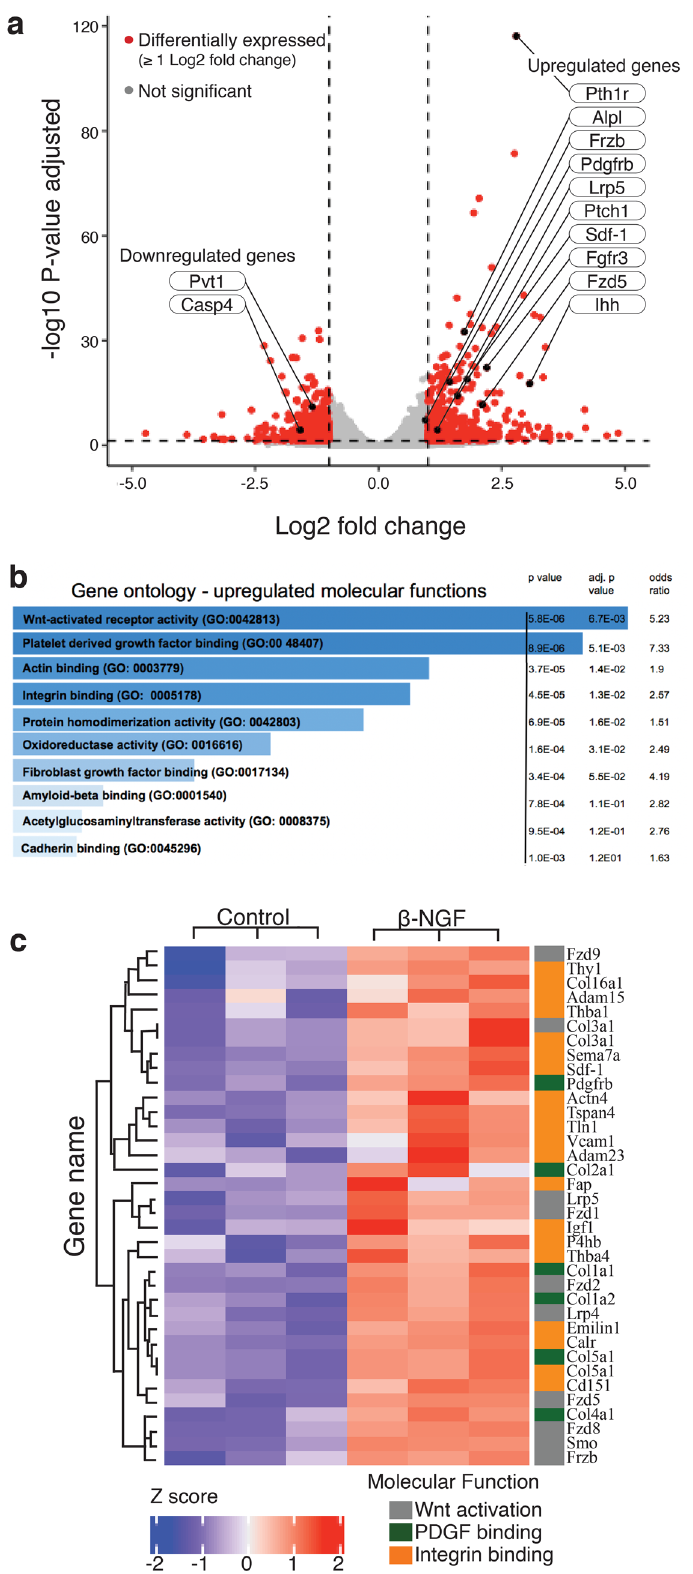
Figure 3. Recombinant human β-NGF (β-NGF) promotes gene expression profile for endochondral bone formation. ( a ) Volcano plot of differentially expressed genes in hypertrophic cartilage stimulated with β-NGF. Threshold set to ≥ 1 log2 fold change (equal to ≥ twofold change), endochondral ossification-associated markers are denoted (n = 3). ( b ) Upregulated molecular function categories generated by EnrichR (maayanlab.cloud/Enrichr/), gene ontology terms are sorted by p values with corresponding adjusted p value and odds ratio ( c ) Heatmap depicting relative expression of genes associated with Wnt activation, PDGF binding, and integrin binding. p < 0.05, Benjamini–Hochberg method. Panel a was generated by the R package ggplot2 (version 3.2.1) 84 . Panel c was generated by Complexheatmap (version 2.0) on Bioconductor